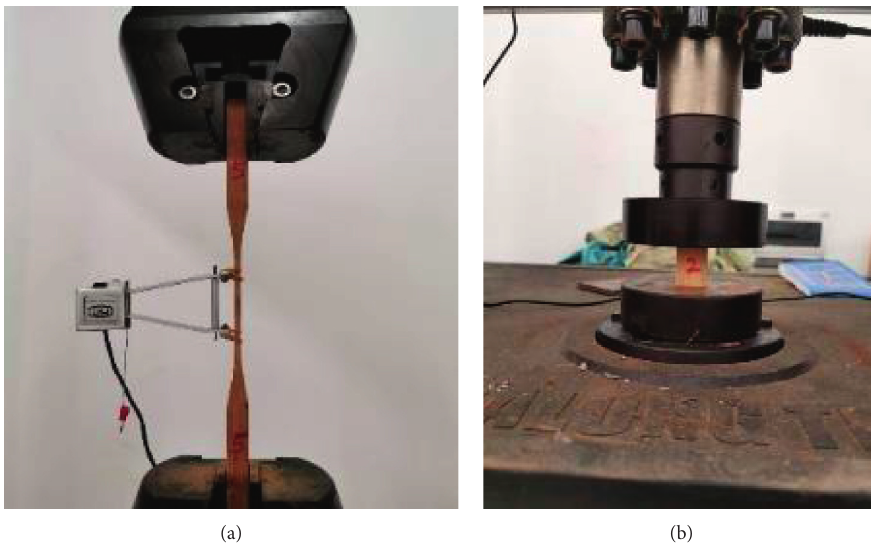
Figure 2: Testing field. (a) Tension test. (b) Compression test.